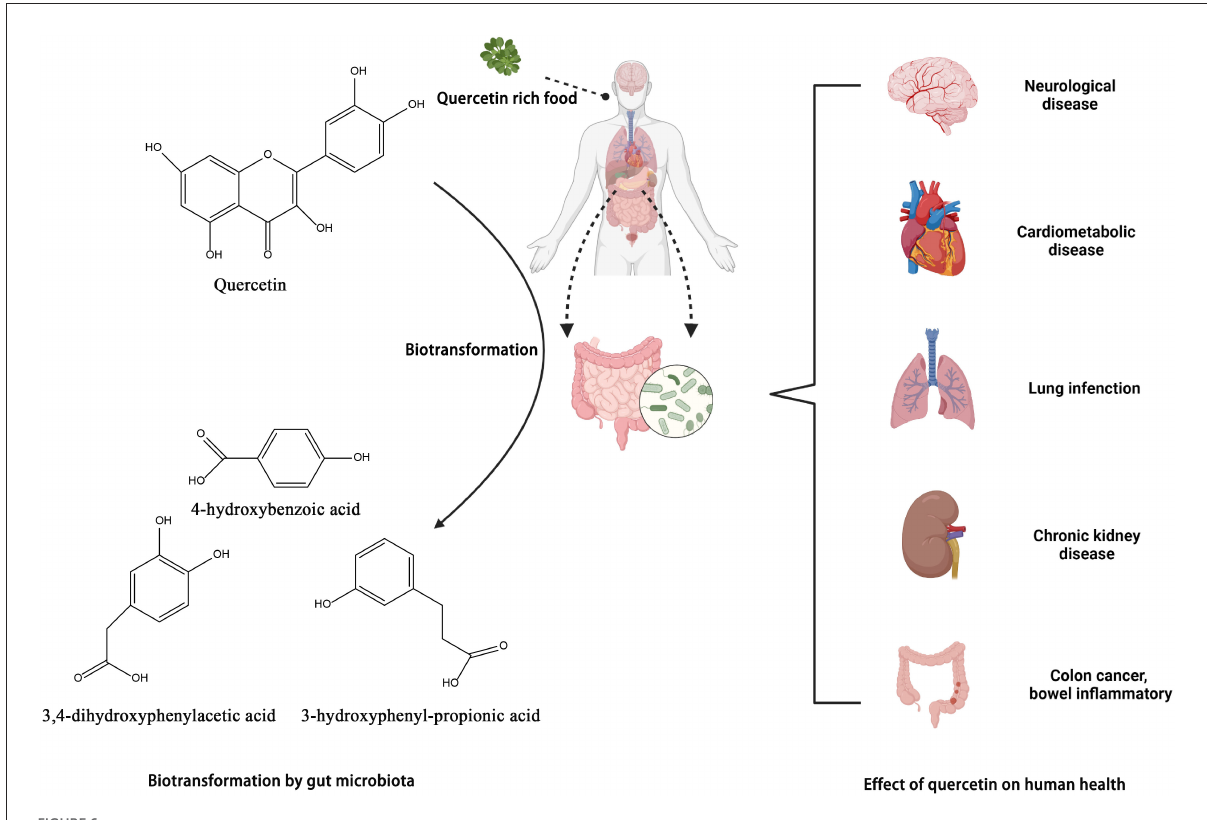
FIGURE6 Biotransformation of quercetin into metabolites by gut microbiota and their benefits in gut. Created with BioRender.com.